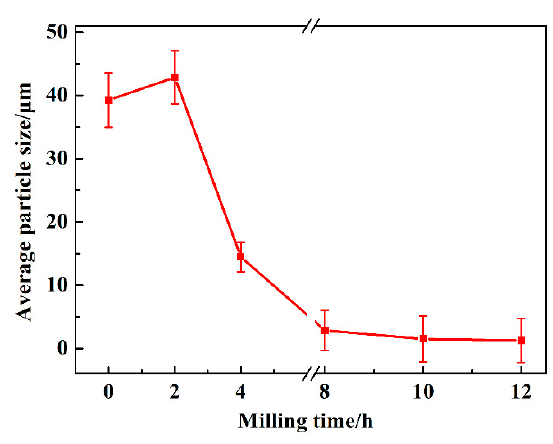
Figure 5. The average particle size of Cu-Cr alloying powders as a function of milling time.